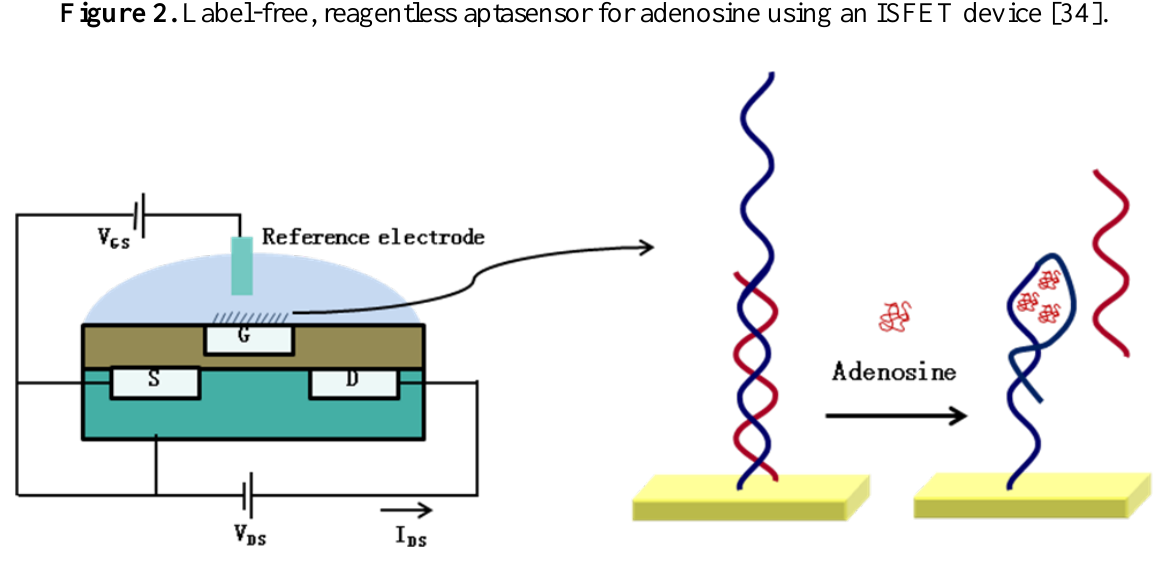
Figure 2. Label-free, reagentless aptasensor for adenosine using an ISFET device